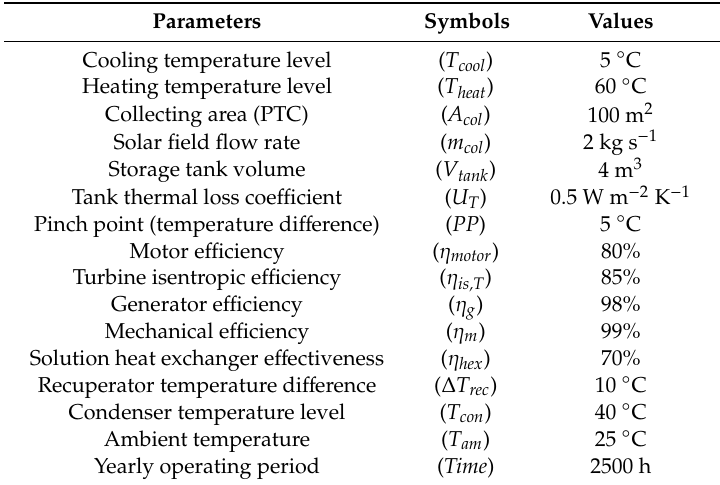
Table 2. Main parameters of the present work.